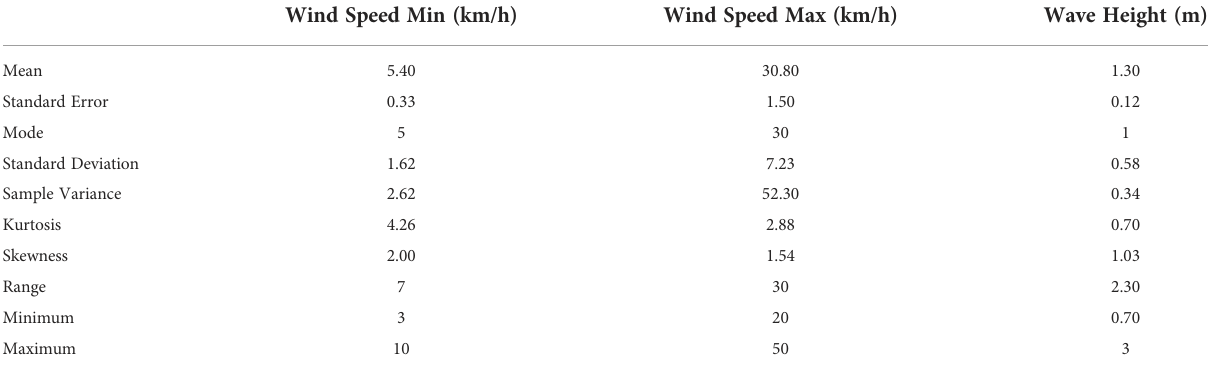
TABLE 1 Weather thresholds for wind speed and wave height given by fi shers ’ meteorological knowledge